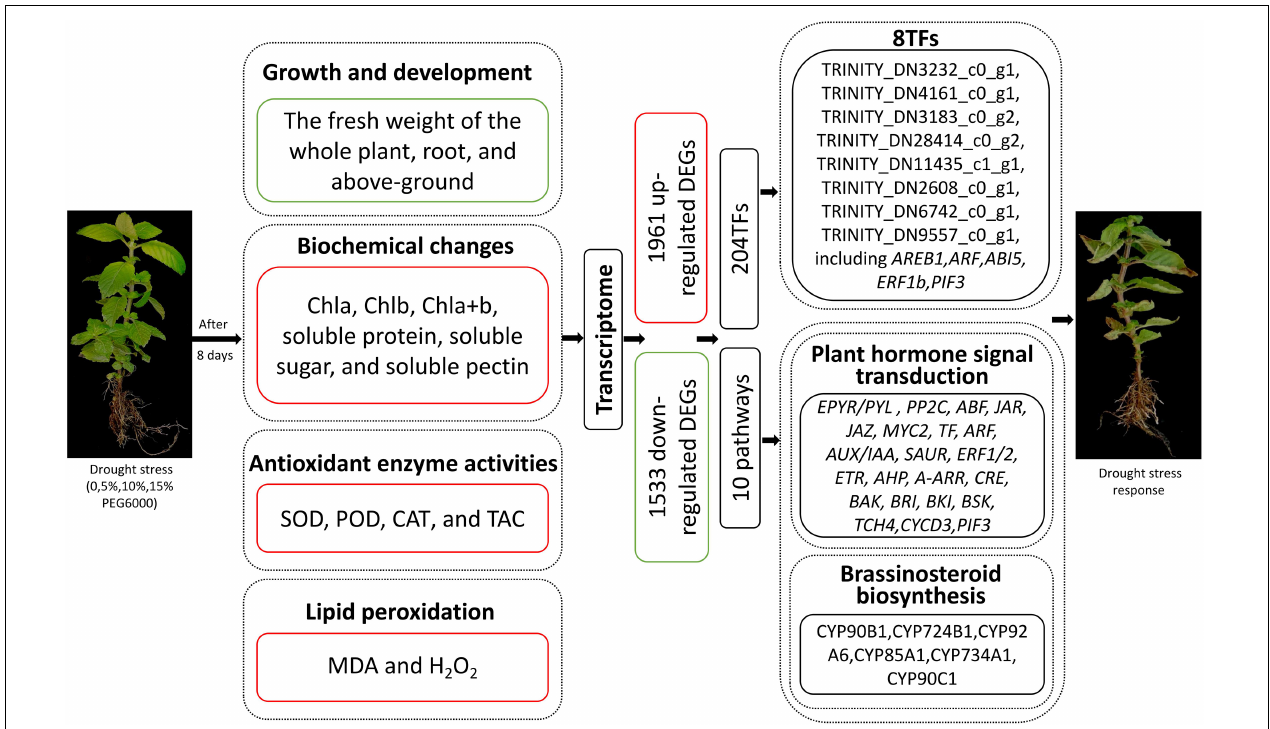
FIGURE 13 | Overview of drought stress affecting the growth and development of MCB. Red boxes and words indicated up-regulation; green boxes indicated down-regulation.